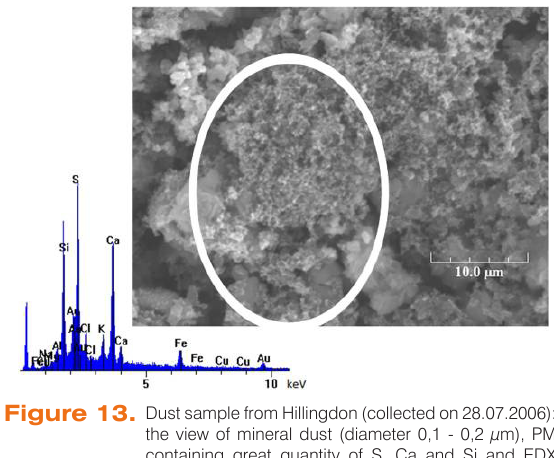
Figure 9. Dust sample from Hillingdon (collected on 06.07.2006), the view of bright particle with Fe and Sb content and EDX spectrum